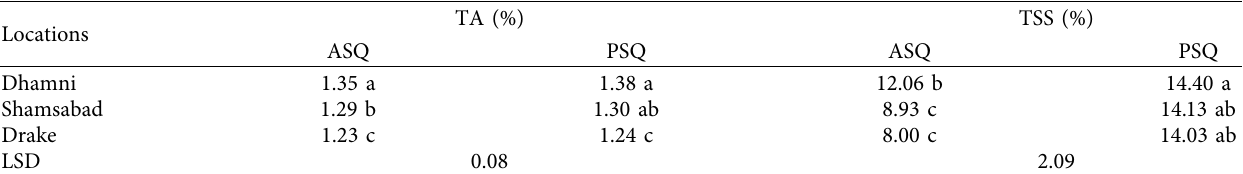
Figure 1: Effect of different elevations on (a) fruit weight of two different quince ecotypes and (b) correlation among soil N contents and fruit weight of two quince ecotypes. ASQ: apple-shaped quince; PSQ: pear-shaped quince. Vertical bars indicate standard error of means ( ± SEM) for three replicates. Table 1: Titratable acidity (TA) and total soluble solids (TSS) of two quince ecotypes from three different locations of Rawalakot, Azad Jammu and Kashmir.